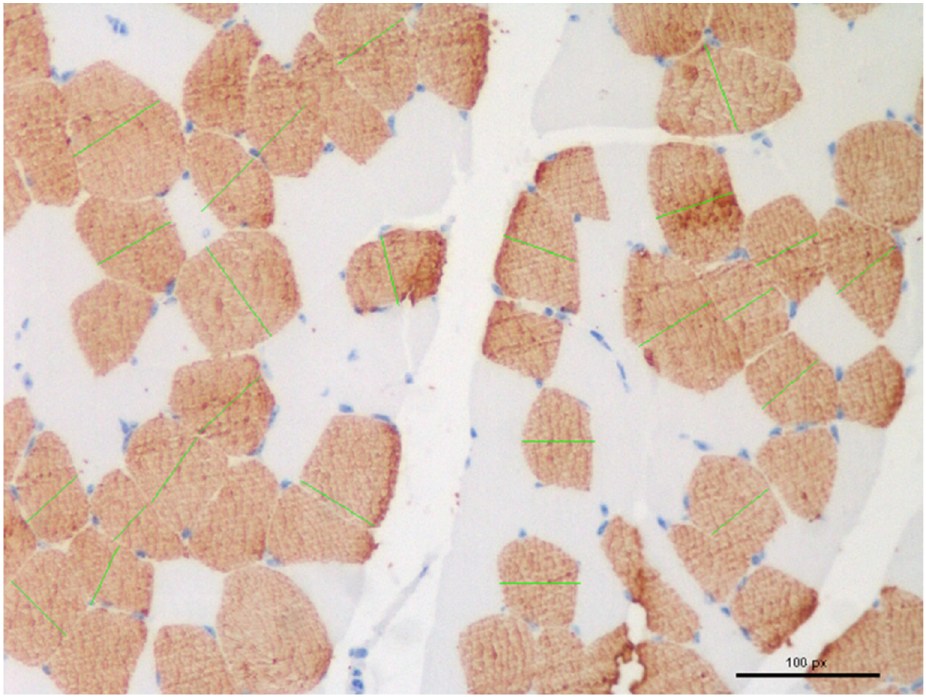
Figure 1. Selection and measurement (green lines) of muscle fibre for diameters calculations in randomly chosen fields. Table 1. List of selected targets for Gene expression study, reference sequences, amplicon sizes and supplier references for each Taqman assay. Reference gene for data normalisation marked with *. Taqman Assay